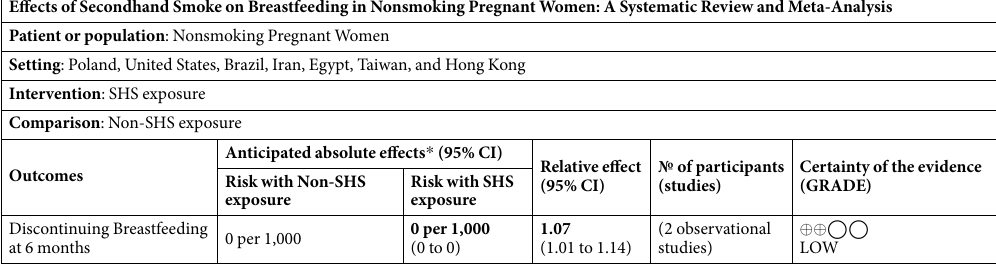
Table 3. Summary of findings of discontinuing breastfeeding at 6 months. * The risk in the intervention group (and its 95% confidence interval) is based on the assumed risk in the comparison group and the relative effect of the intervention (and its 95% CI). CI: Confidence interval; MD: Mean difference; OR: Odds ratio; HR: Hazard Ratio. GRADE Working Group grades of evidence . High certainty: We are very confident that the true effect lies close to that of the estimate of the effect. Moderate certainty: We are moderately confident in the effect estimate: The true effect is likely to be close to the estimate of the effect, but there is a possibility that it